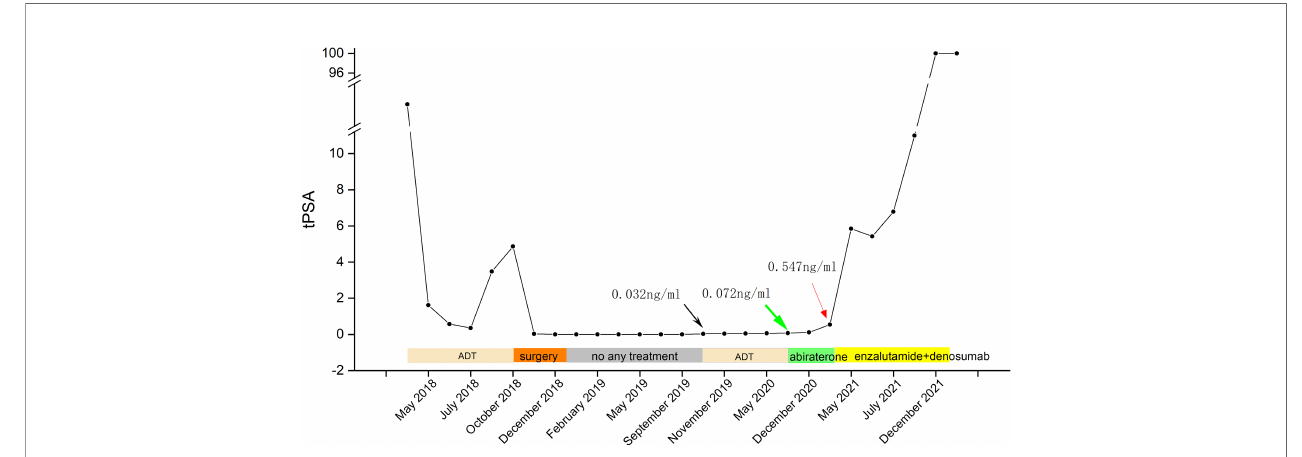
FIGURE 5 | Timeline of the PSA level and treatment (green arrow — a positive result of 18 F-PSMA-1007 PET/CT imaging with a PSA of 0.072 ng/ml; black arrow — an elevated PSA of 0.032 ng/ml; red arrow — an elevated PSA of 6.79 ng/ml).